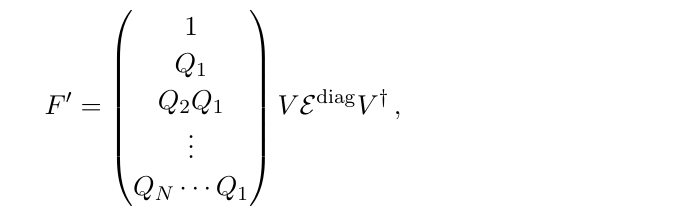
F 0 is a 3( N +1) (cid:2) 3 matrix whose three columns are the three zero mode wave functions and E is the same matrix encountered in eq. (2.11). Notice that each site has three (cid:12)elds living on it, and accordingly each wave function has three components per site.